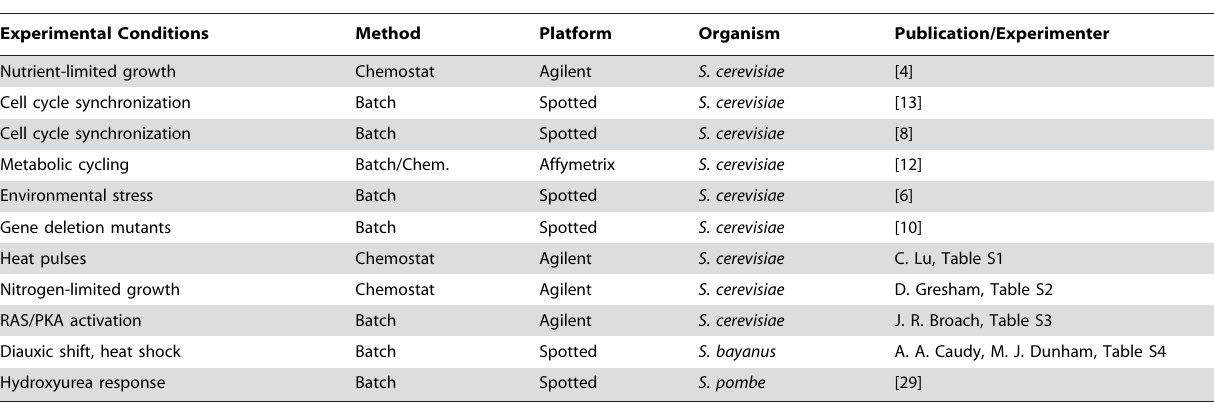
Table 1. Overview of expression data analyzed in this